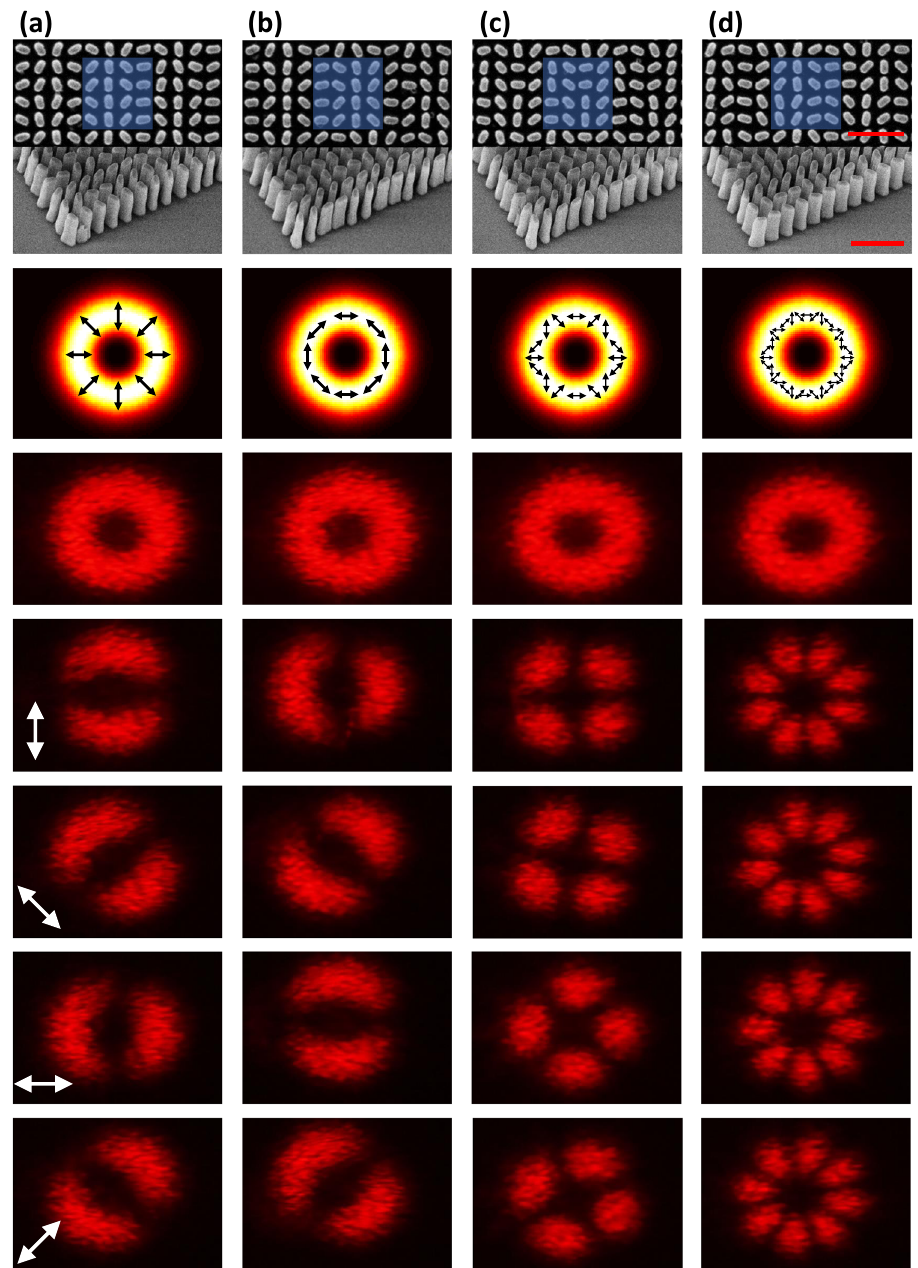
Fig. 4 Fabricated results and optical measurement of the Stokes polarization parameters of the donut polarization-distributed fi eld pro fi le. Field distribution with a l = 1, m = 0; b l = 1, m = 1; c l = − 2, m = 0; d l = − 4, m = 0. Top row: fabricated results with the top view (top panels) and tilt view (bottom panels). The blue area shows one pixel of the meta-hologram. The red scale bar represents 1 μ m. Second row: intensity pro fi les of the designed vectorial fi elds. The black arrow represents the local polarization. Third row: measured intensity pro fi les of the fi eld distributions without linear polarizer. Fourth to seventh rows: measured intensity pro fi les of the fi eld distributions with a linear polarizer. The white arrow represents the transmission axis of the linear